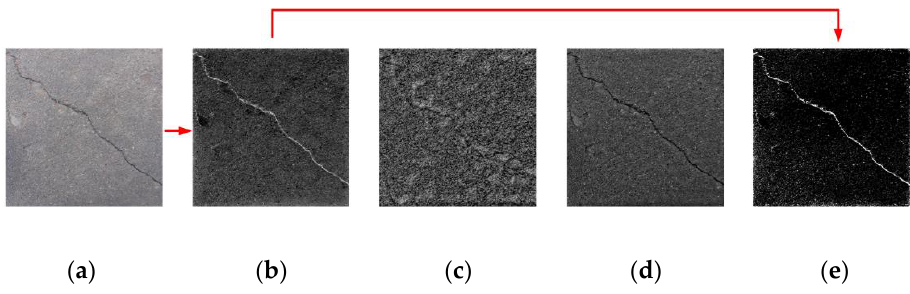
Figure 2. ( a ) Original image containing a crack, and the crack feature extraction results treated by: ( b ) Gaussian filter; ( c ) Butterworth filter; ( d ) ideal high pass filter for homomorphic filtering; and ( e ) the Otsu thresholding method.